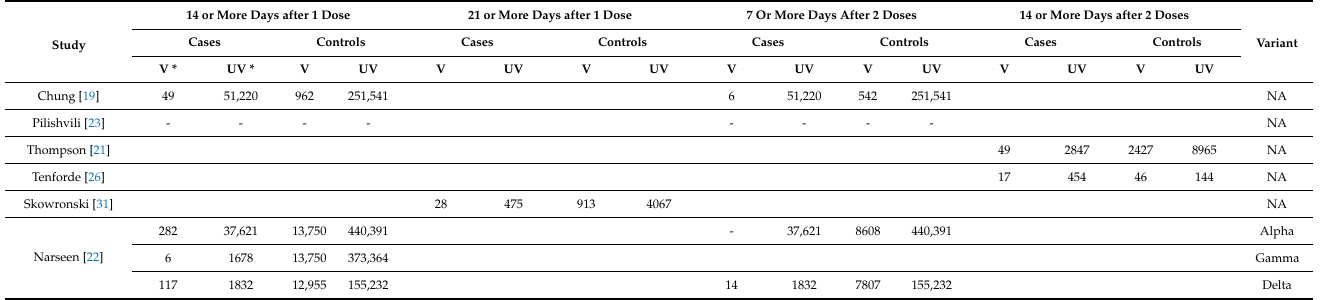
Table A2. Characteristics of mRNA-1273 vaccine vaccinated